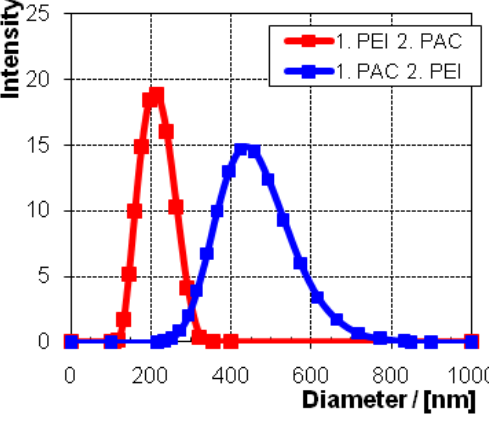
Figure 3. DLS data on PEC-0.6 (0.001 M) for ( A ) 1. PEI 2. PAC (related to full circle in